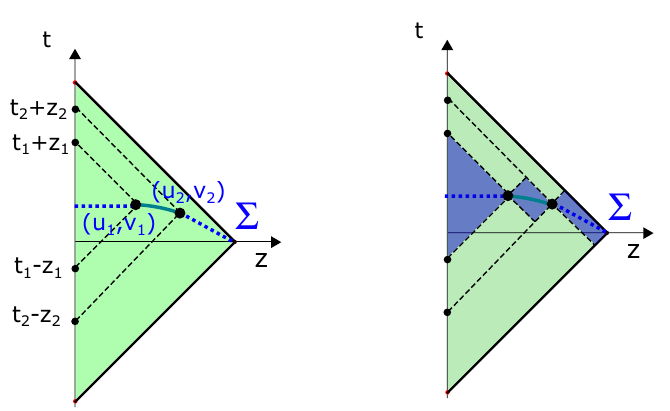
Figure 6 . Left: matter entanglement of a bulk interval between ( u 1 ; v 1 ) and ( u 2 ; v 2 )). Right: the Cauchy slice (cid:6) can be deformed into those new surfaces within the blue regions that respect the spacelike nature.